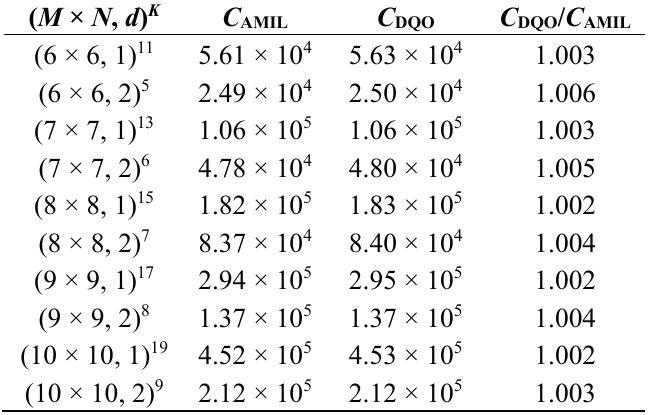
Table 3. Complexity of AMIL and DQO algorithms in ( M × M , d ) K with interval =